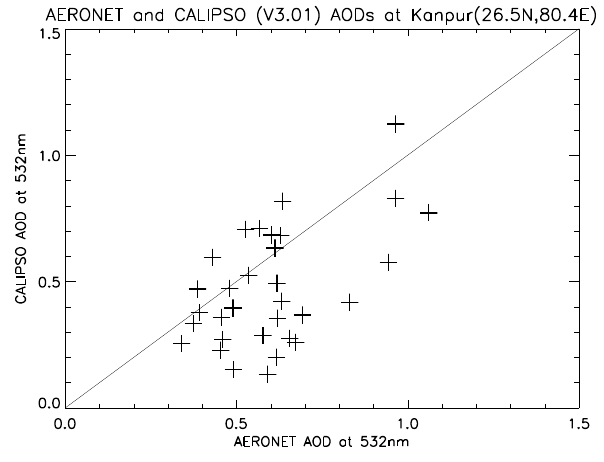
Fig. 10. Comparison of monthly mean column AODs from CALIPSO (version 3) and AERONET station at Kanpur (level 2 version 2 data). All daytime data between June 2006 and December 2009 from CALIPSO were used.